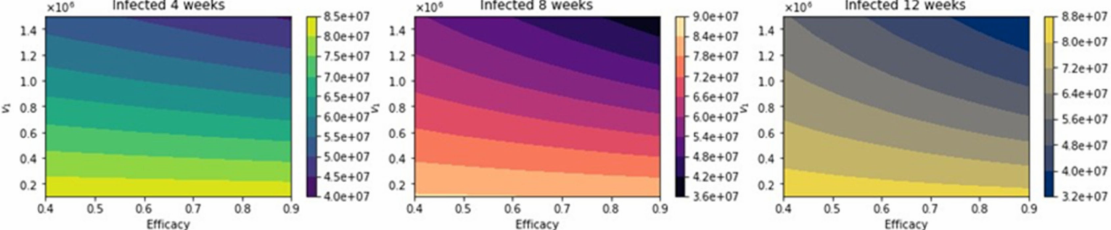
Figure 10. Total number of infected people for a variety of vaccine efficacies after the first dose and different vaccination rates per day. The basic reproduction number R 0 >